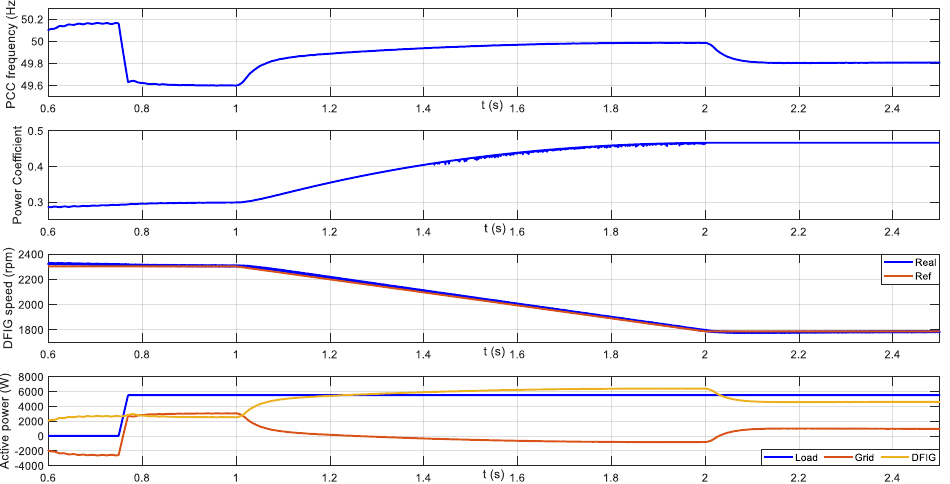
Figure 17. PCC frequency, CP coefficient, DFIG speed, and active power. Frequency drop compensation for the resistive load in the scheme in Figure 14 with the DFIG working deloaded.